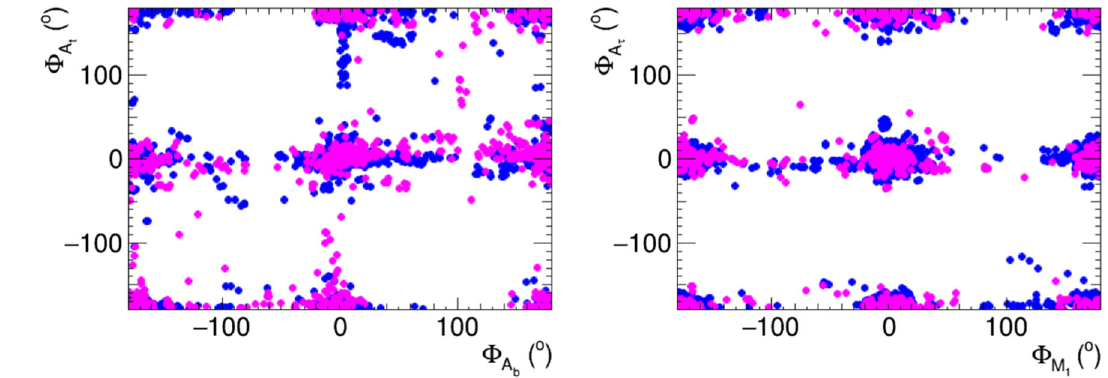
,φ ) (left) and constraints. Blue: including possible future proton EDM constraint, A t b assuming a central value of zero; magenta: including possible future